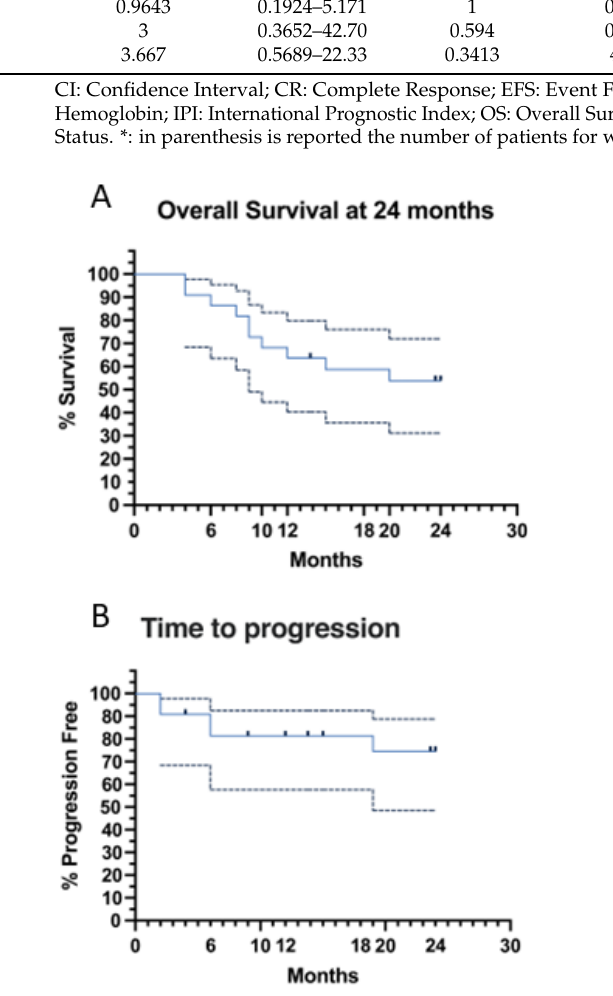
Figure 3. ( A ) Overall Survival (OS) estimated at 24 months is 54%; ( B ) Time to Progression (TTP) estimated at 24 months is 74%.